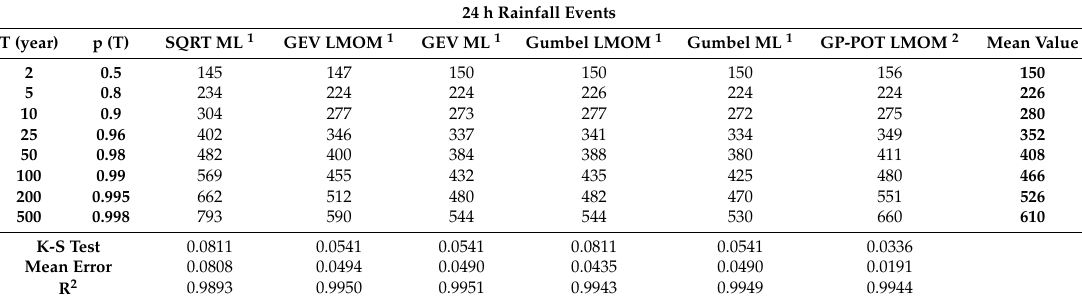
Table 1. Rainfall quantiles obtained by fitting different frequency distribution functions. Parameter estimation methods for frequency distribution functions: L-moments (LMOM); and, Maximum Likelihood